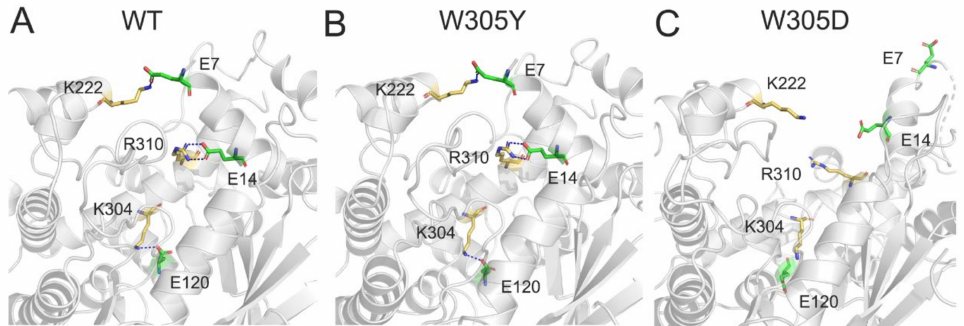
Figure 7. The salt bridges between the interface of DAPK1 and CaM in the WT ( A ), W305Y ( B ), and W305D ( C ) systems. Salt bridges are shown by blue dotted